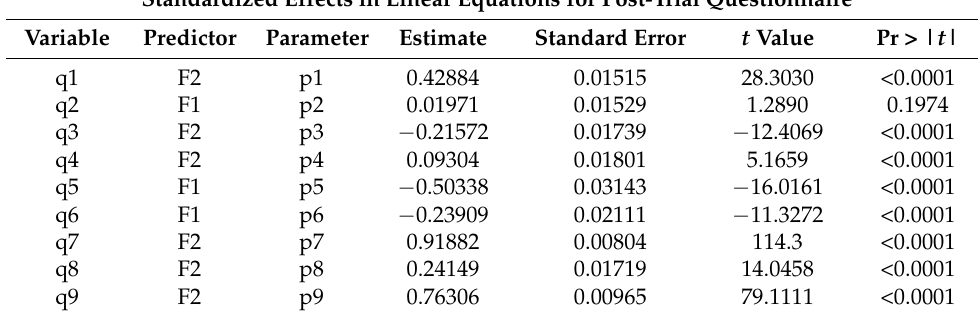
Table 9. Factor loadings for the post-trial questionnaire data set. Standardized Effects in Linear Equations for Post-Trial Questionnaire